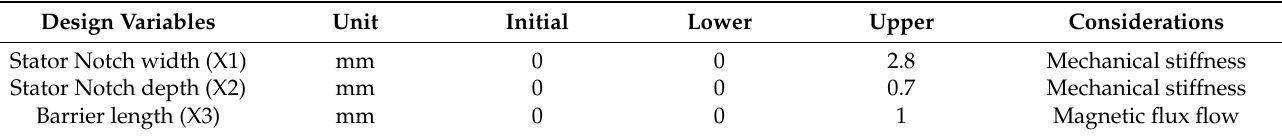
Table 2. Range of design